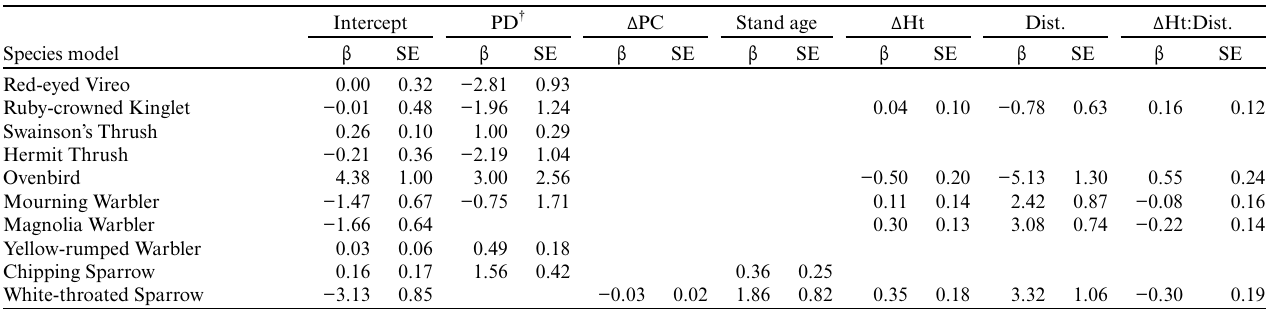
Table 6. Parameter estimates from linear models examining variation in within-stand trends (circa 1994 to 2014) in abundance for 10 passerine species in aspen-dominated mixedwood forests of central Saskatchewan. Model coefficients ( β ) and standard errors (SEs) are included for the covariates from the selected models. PD = proportional change in original stand area, Δ PC = change in proportion of canopy composed of coniferous trees, Dist. = disturbance (disturbed = 1, undisturbed = 0), Δ Ht = change in stand height. Parameter values were rescaled by multiplying by a constant (100) for ease of presentation; divide by 100 to obtain estimates. None of the models contained coefficients for Windthrow or Park effects. Intercept PD † Δ PC Stand age Δ Ht Dist.